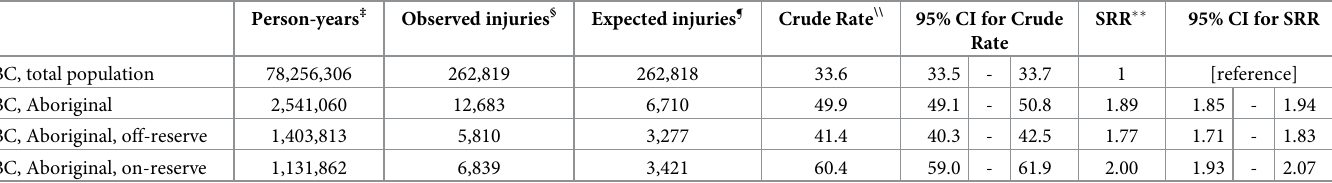
Table 1. Hospital Separations due to unintentional transport injuries (cid:3) , British Columbia,